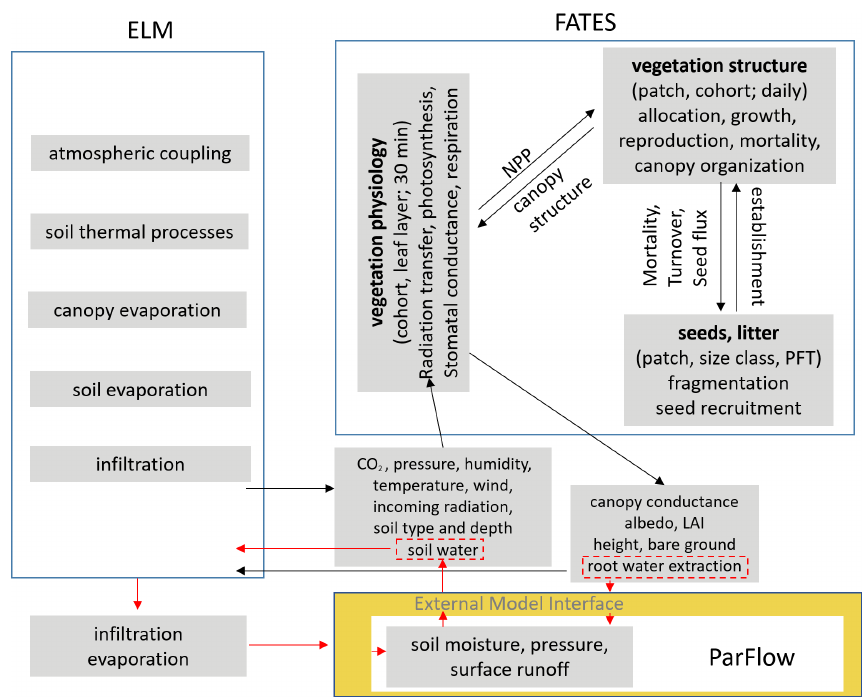
Figure 1. Schematics of ELM, ParFlow, and FATES and the approach to coupling the three models. Hydrology in ELM is replaced by ParFlow. Arrows show the passing of variables between models. Black arrows indicate the exchange of variables within FATES and between ELM and FATES. Red arrows highlight the exchange of variables between ELM and ParFlow. Interactions between FATES and ParFlow are mediated through ParFlow’s influence on soil water and FATES’ influence on root water extraction, shown in the red dashed